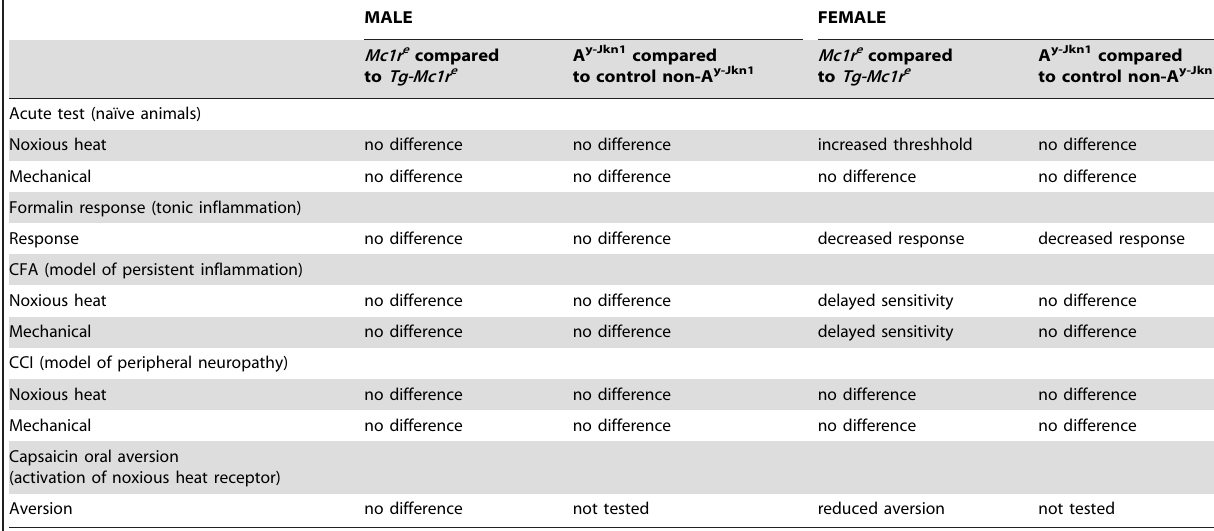
Table 1. Summary of